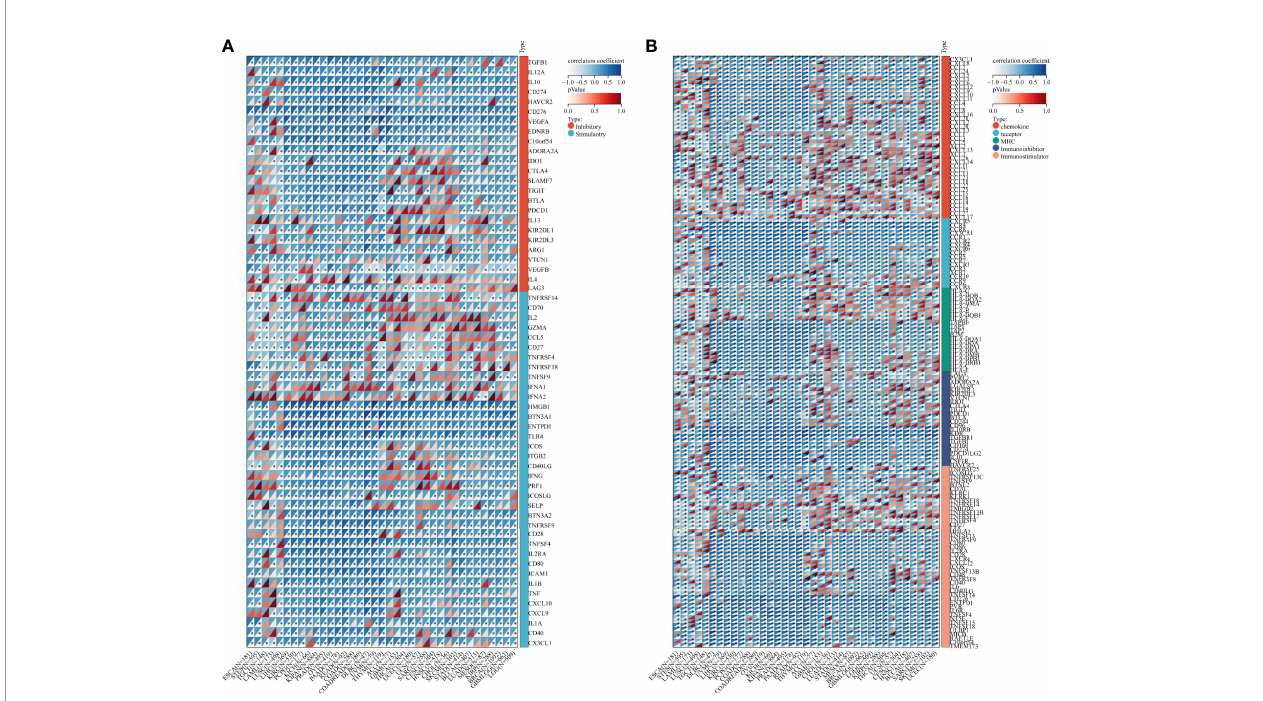
FIGURE 6 | Bioinformatics analysis of the immunomodulatory role of ADAM17 in multiple cancer types. (A) Correlation between ADAM17 and 60 genes related to immune checkpoints. (B) Correlation between ADAM17 and 150 immunomodulators (41 chemokines, 18 receptors, 21 MHCs, 24 immunoinhibitors, and 46 immunostimulators). * P <